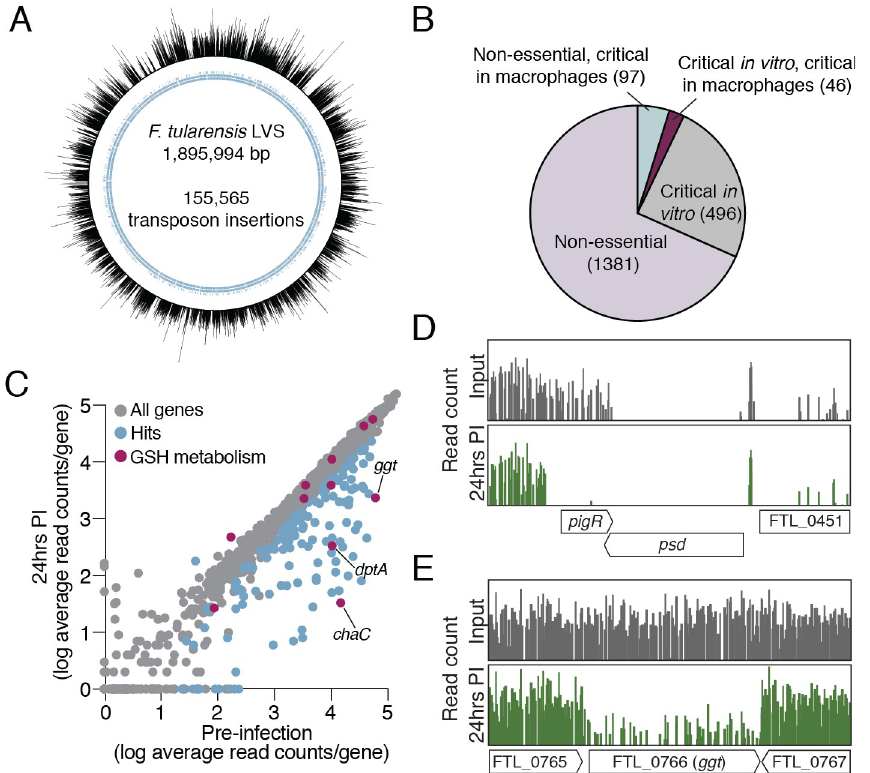
Fig 1. Highly saturated Tn-Seq screen in F . tularensis LVS to identify genes required for intramacrophage growth. (A) Map of transposon insertions across the F . tularensis genome. Of all the potential transposon insertion sites (TA dinucleotides) genome-wide, 75% contain a transposon insertion. Each line corresponds to one mutant with a single insertion; the line height corresponds to the relative abundance of sequencing reads identified for each individual insertion. Blue inner circle represents genes. (B) EL-ARTIST and Con-ARTIST analysis of Tn-Seq screen reveals genes that are non-essential under any tested condition (lavender), critical in vitro (grey), critical in vitro and in macrophages (maroon), and those that are non-essential in vitro but critical in macrophages (blue). (C) The relative abundance of mutations in each gene (average read count per gene) in the mutant pool used to infect J774A.1 cells (pre-infection) and in mutants recovered after 24 hours of infection. Genes significantly more or less abundant after infection (at least 2-fold changed, with 4 or more informative insertion sites, p < 0.05) are colored in blue. Genes involved in GSH metabolism are highlighted in purple. (D-E) Transposon insertion profiles for the indicated genetic regions from the input library (grey) and 24 hr post infection (green). Line height represents the relative abundance of sequencing reads at that position on a log